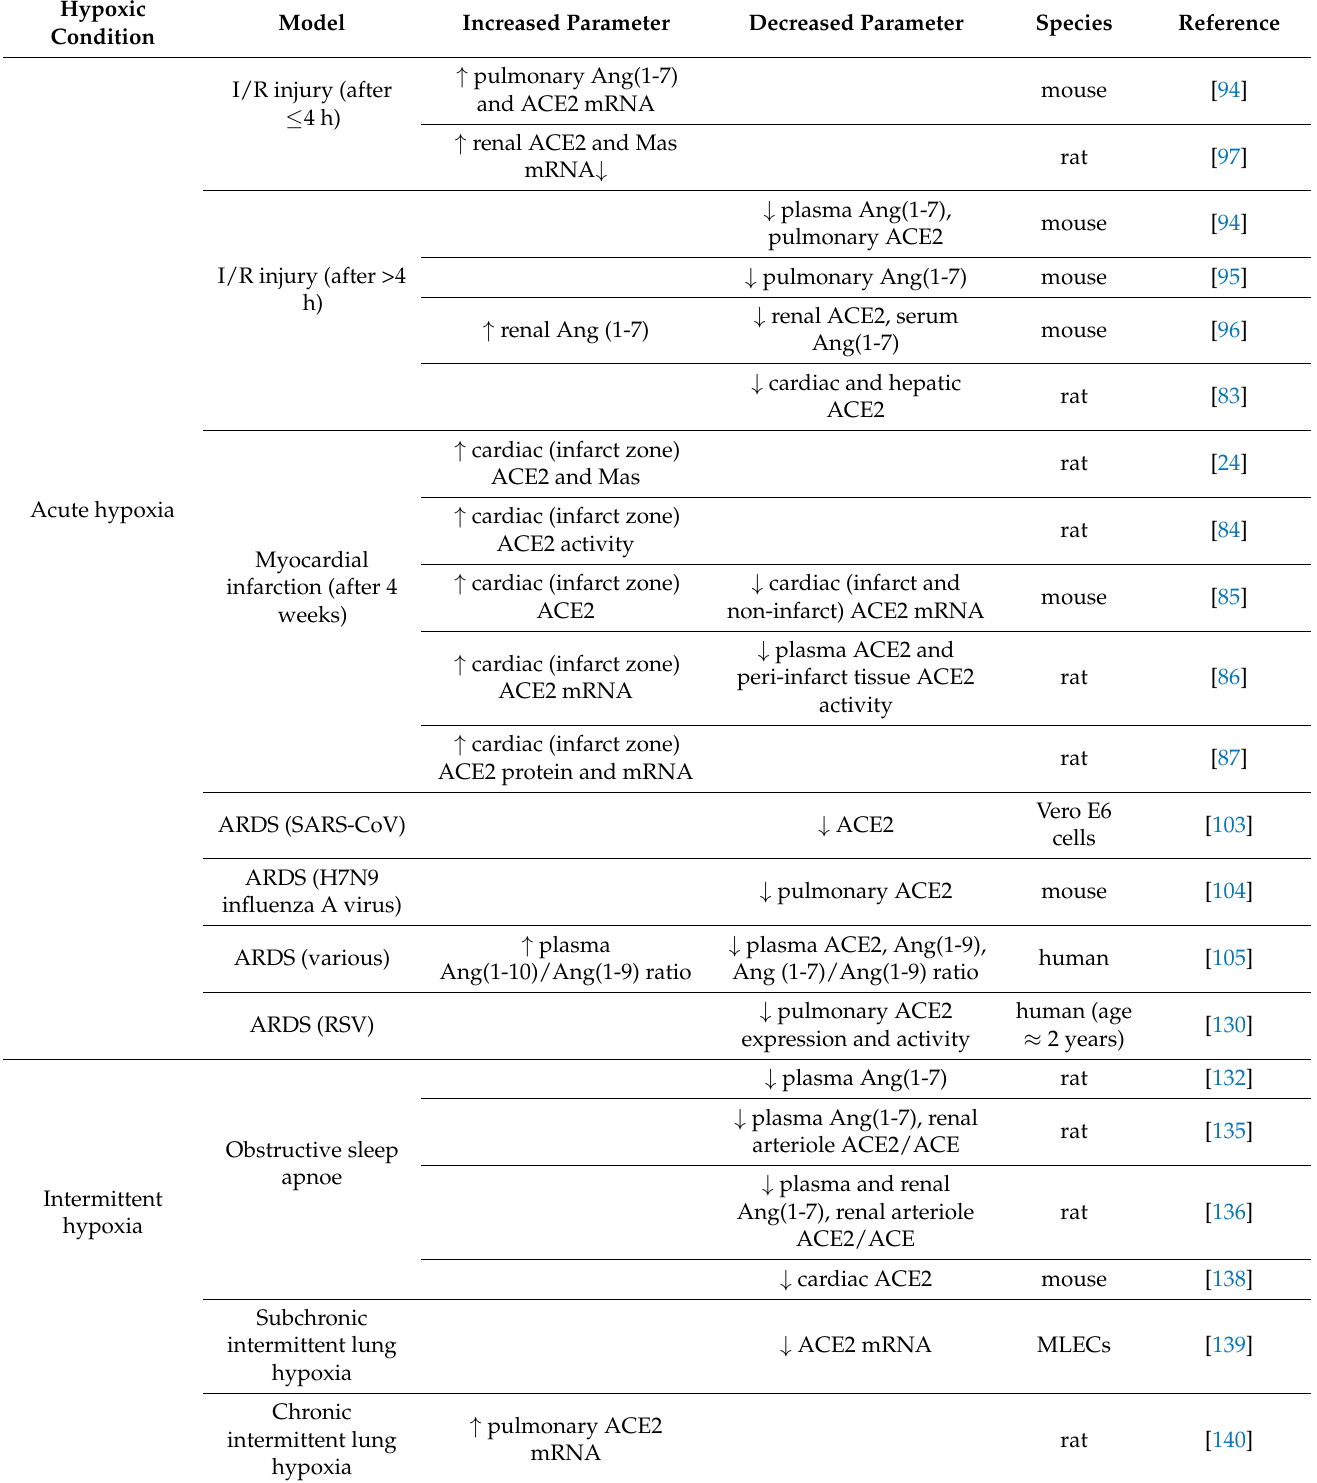
Table 1. Overview of ACE2/Ang(1-7)/Mas parameters alteration in CVS and pulmonary hypoxia